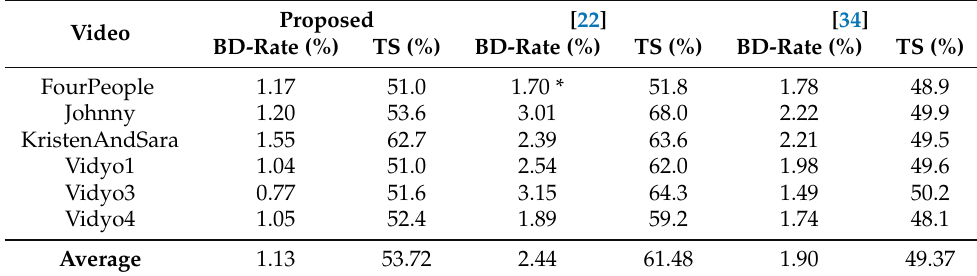
Table 9. Encoding performance of the proposed overall method compared with the anchor method and previous works for six visual sensor video sequences. Video